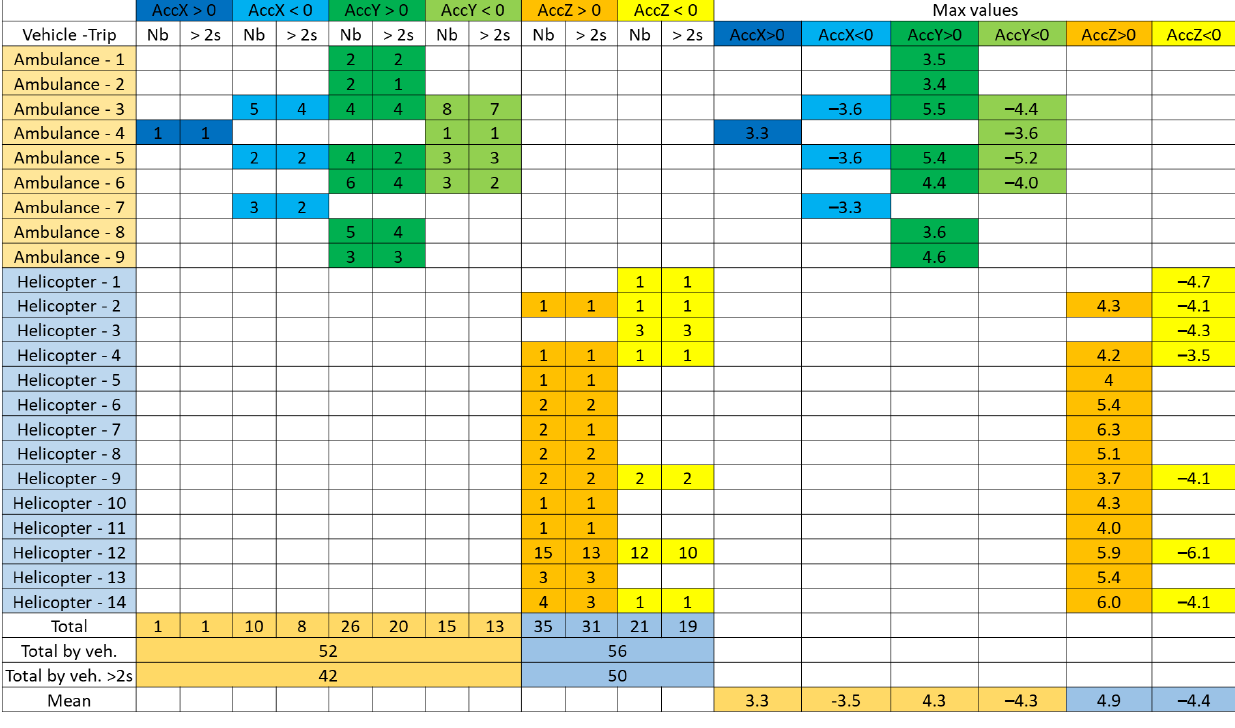
Figure 10. Number (total, spaced more than 2 s apart) and maximum values of acceleration peaks for the relevant trips.